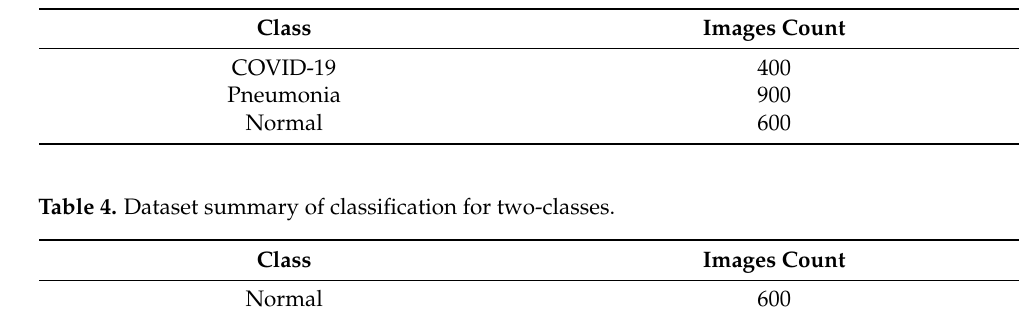
Table 3. Dataset summary of classification for three-classes.